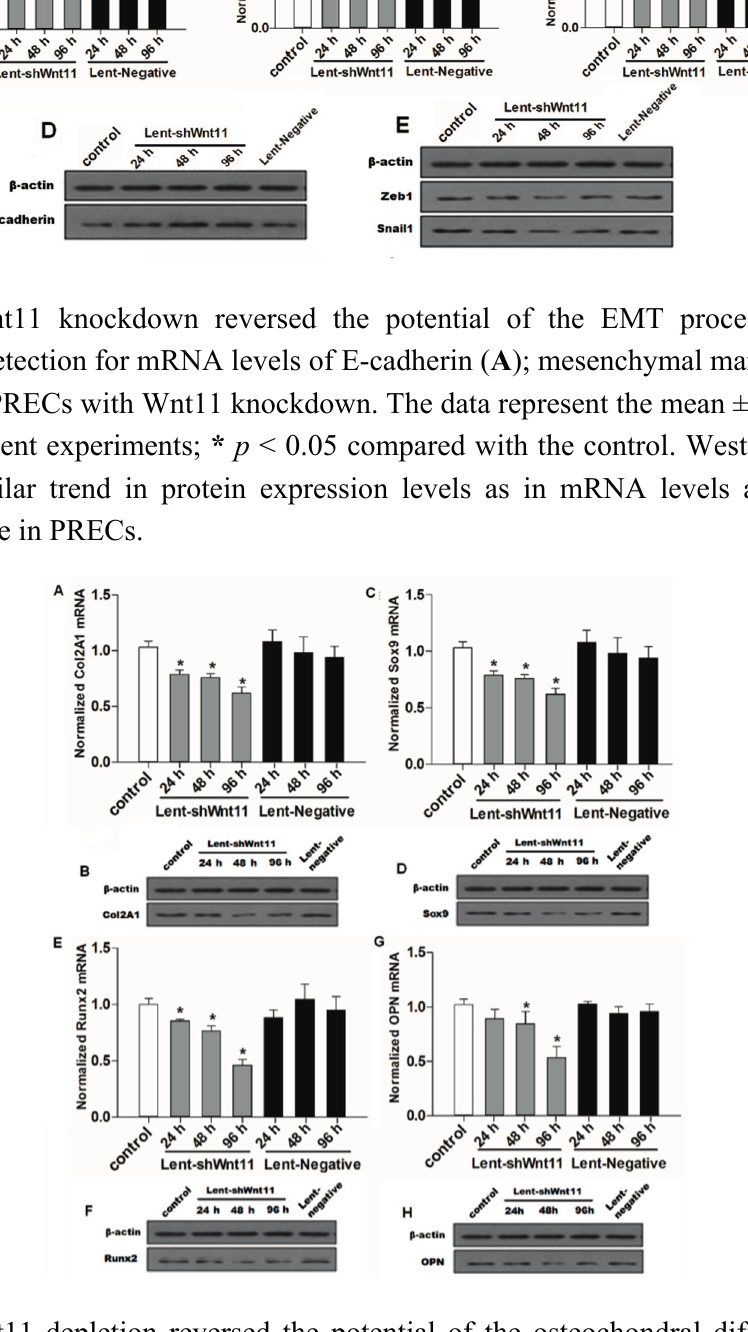
Figure 4. Wnt11 depletion reversed the potential of the osteochondral differentiation in PRECs. Quantitative and qualitative analysis for mRNA and protein levels of osteochondral markers Col2A1 ( A , B ); Sox9 ( C , D ); Runx2 ( E , F ) and OPN ( G , H ) in PRECs with Wnt11 knockdown. The data represent the mean ± SD of at least three independent experiments; * p < 0.05 compared with the